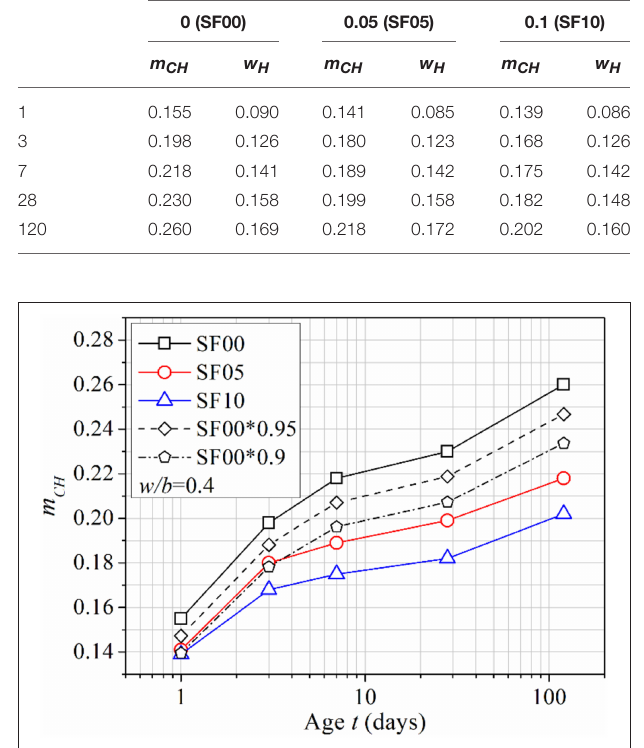
FIGURE 6 | Evolution and comparison of m CH in SF blended